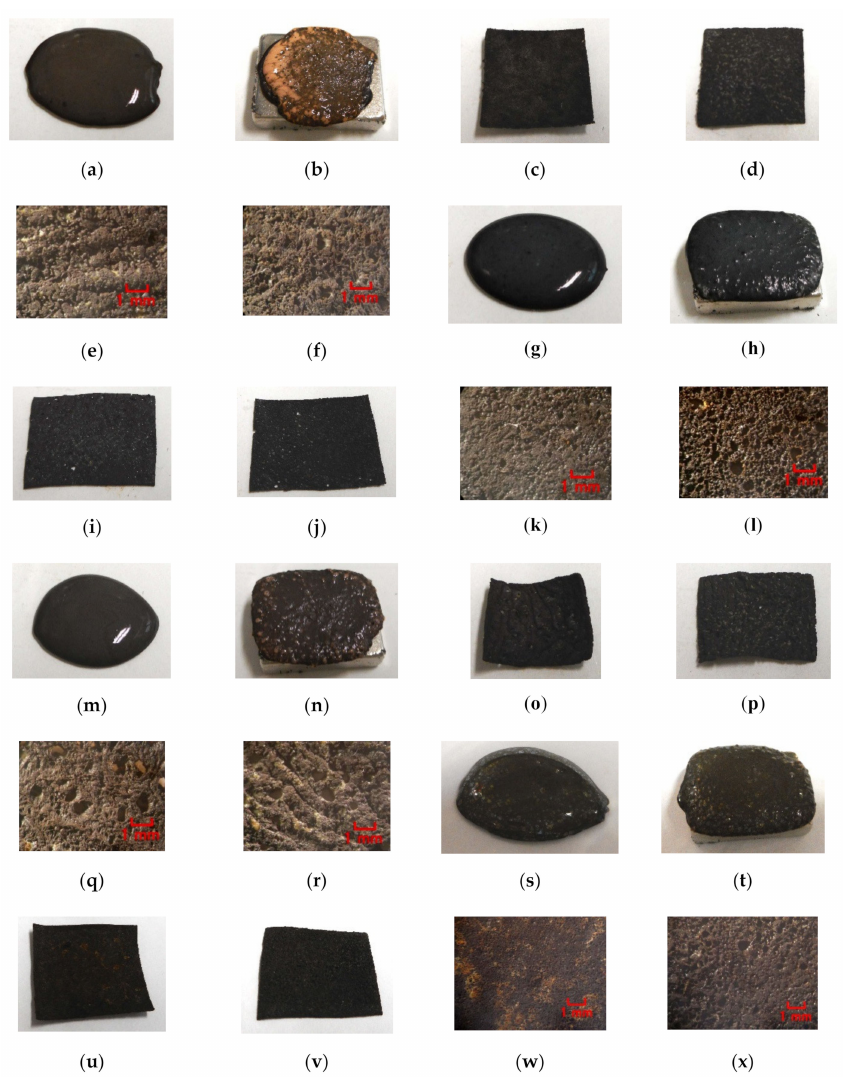
Figure 7. Images of liquid before electrolytic polymerization and mixing electrolytically polymerized rubber with water-insoluble MF: ( a – f ) MSGS60; ( g – l ) A500; ( m – r ) HC50; ( s – x ) DS50; ( a , g , m , s ) liquid before electrolytic polymerization without magnetic field; ( b , h , n , t ) liquid before